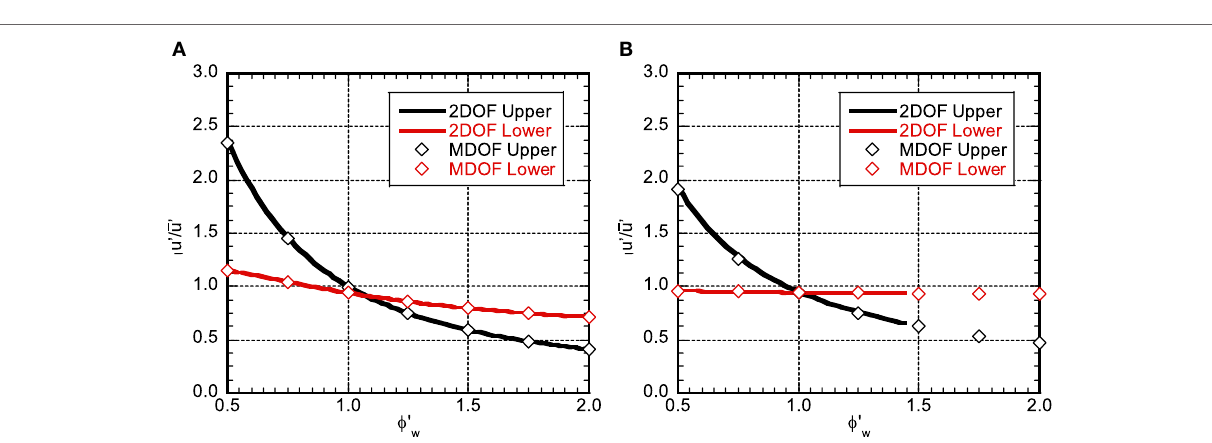
FIGURE 15 | Comparison of time–history responses between 2DOF and MDOF: (A) H w / H :0.2, D 5% and (B) H w / H :0.6, D 5% .